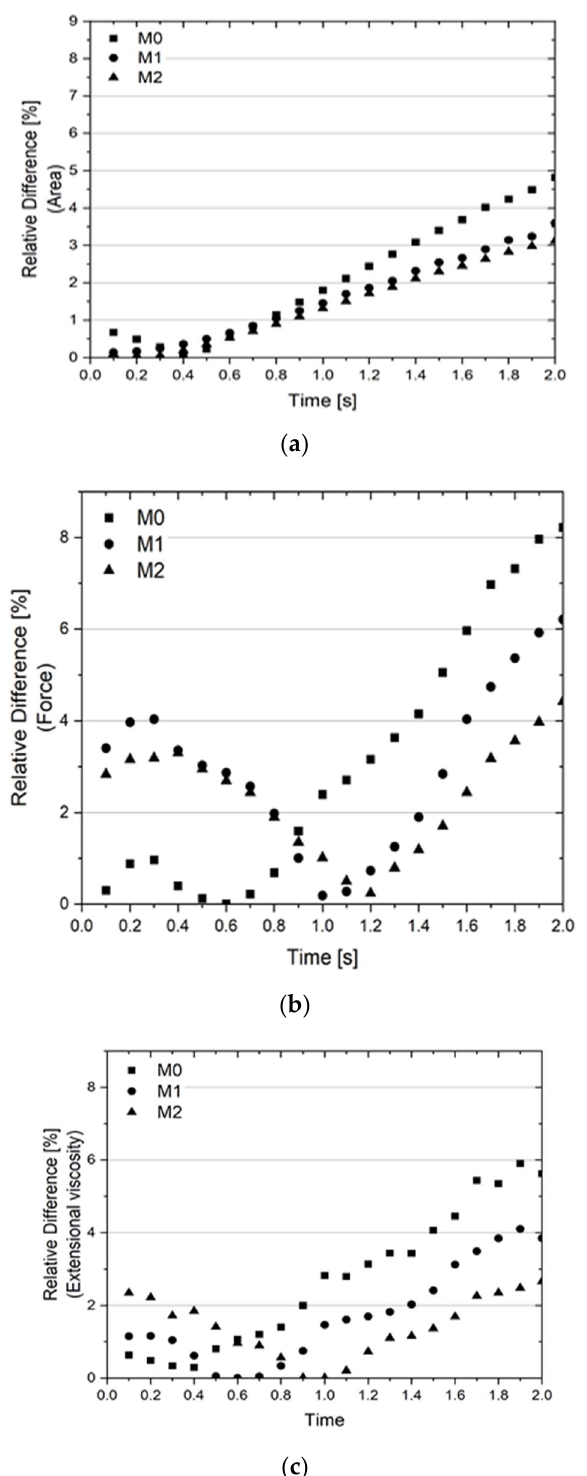
Figure 7. Mesh sensitivity analysis for G2. Relative differences between numerical and theoretical results corresponding to ( a ) cross-section area, ( b ) normal force, and ( c ) extensional viscosity.